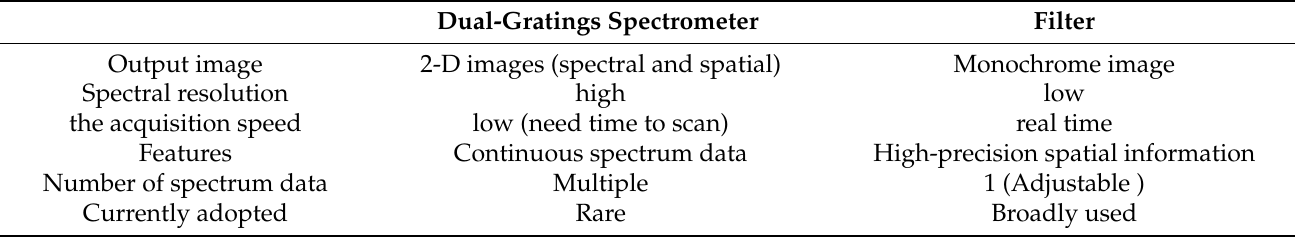
Table 5. Comparison of filter and Dual-gratings